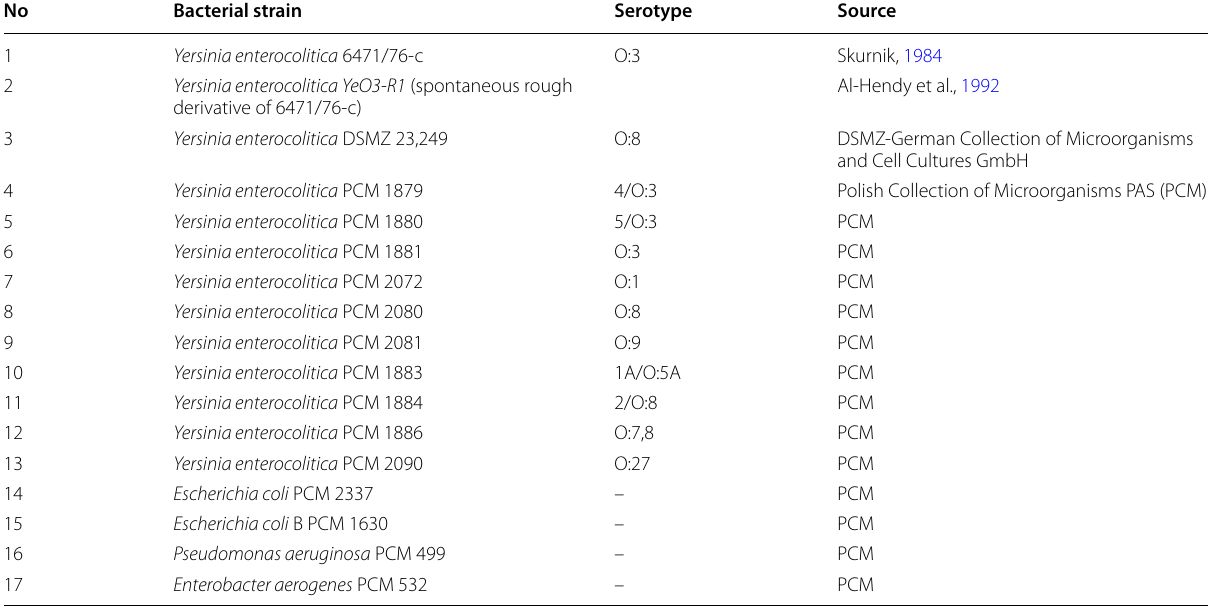
Table 1 Strains used to perform ELISA